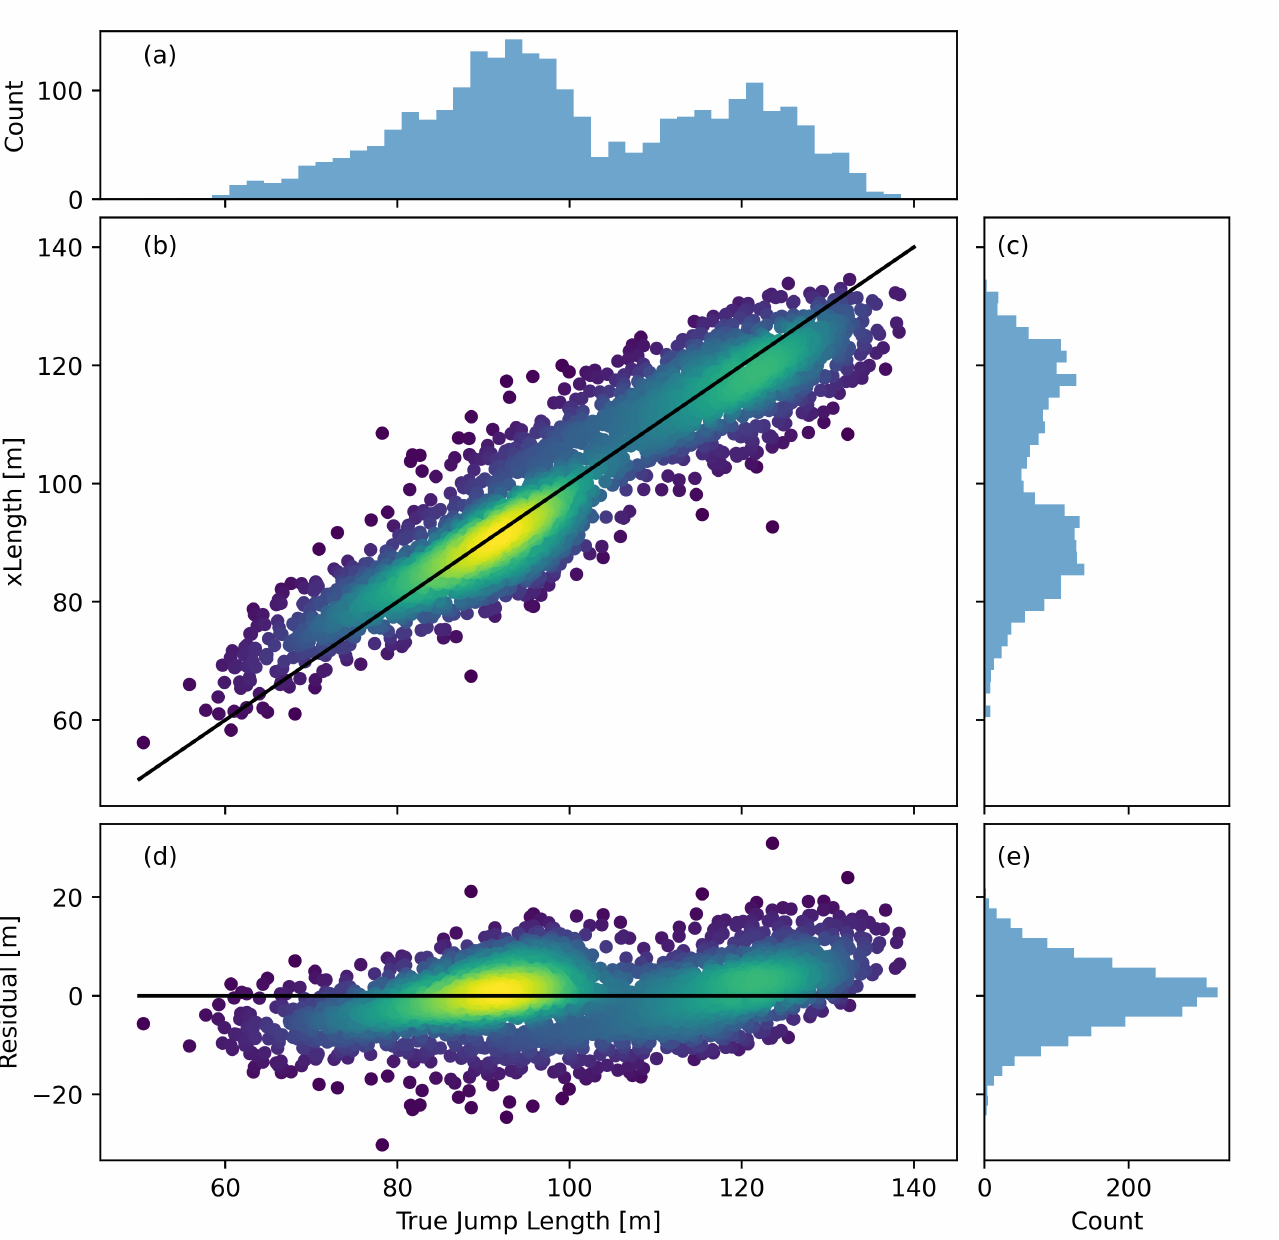
Figure 4. Subplot ( a ) shows the distribution of the true ski jump length in the dataset. Subplot ( c ) shows the distribution of the jump length predicted by the ResNet with the folds split by athletes. In subplot ( b ), the prediction is plotted versus the true jump length. The color represents the density of points calculated using a kernel-density estimate using Gaussian kernels. The brighter the color, the higher the density of the points. Subplot ( d ) shows the residual as a function of the true jump length. The color again represents the density of the points. Subplot ( e ) shows the distribution of the